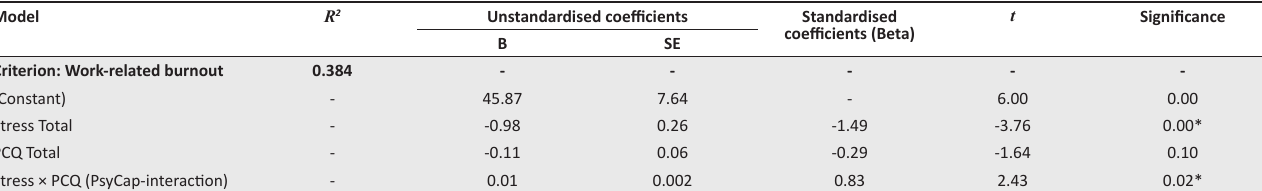
TABLE 4: Moderated regression analysis: Psychological capital as a moderator in the stress, work-related burnout relationship.